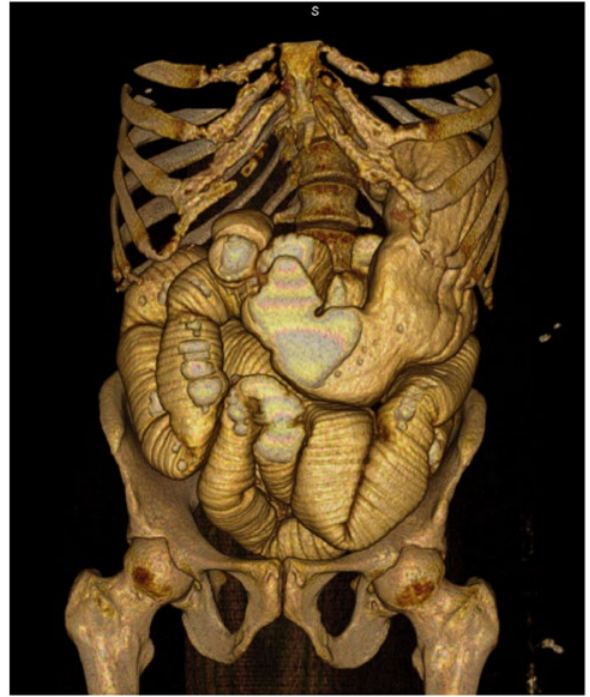
Figure 9b: 3D reconstruction of CT enterography showing marked SBO. Manipulation on the workstation allows accurate evaluation of the transition point